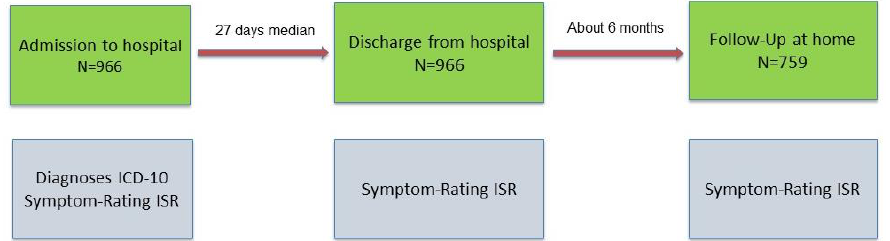
Figure 1. Study design and number of patients. ICD stands for International Statistical Classification of Diseases. ISR stands for ICD Symptom Rating.